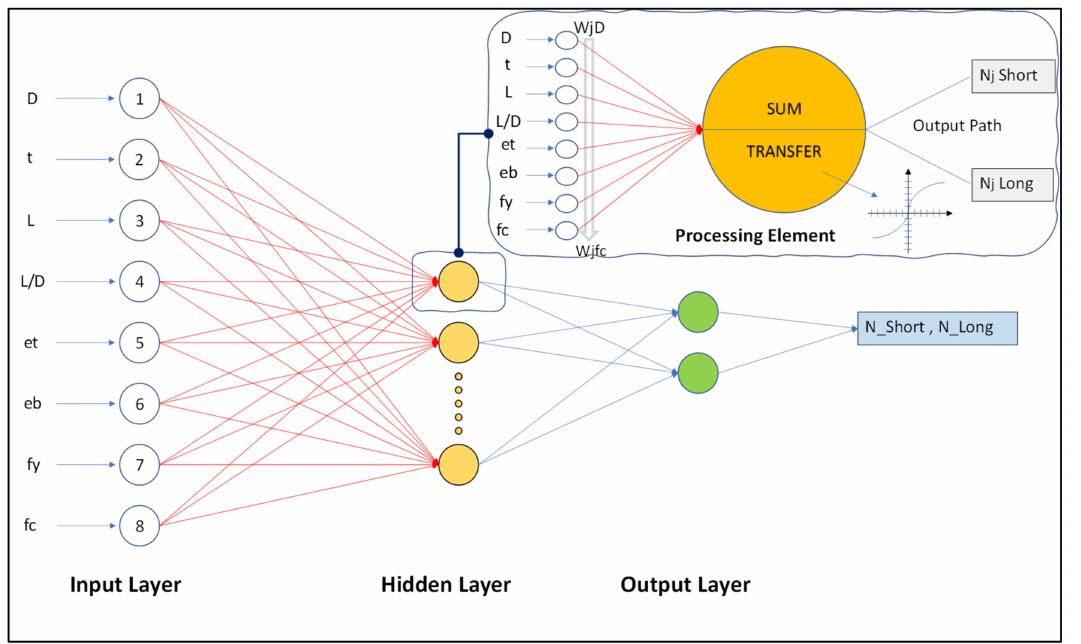
Figure 2. Schematic layout of feed-forward neural networks with eight explanatory